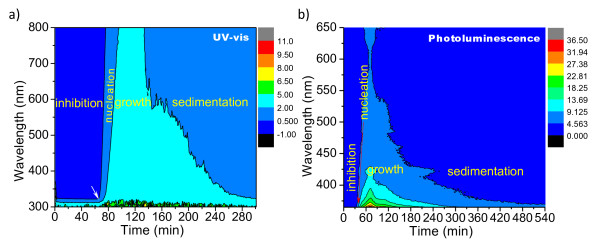
Real-time UV–vis absorbance (a) and PL emission (λex = 350 nm) spectra (b) for TiO2NP precipitation.